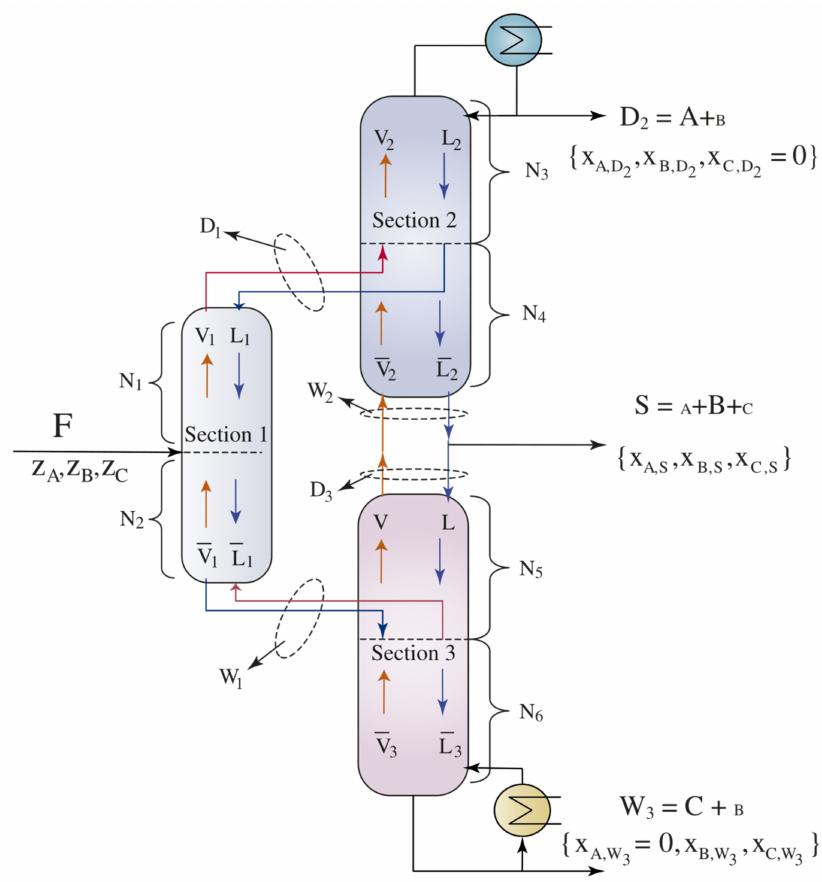
Figure 6. Modeling structure of the Petlyuk